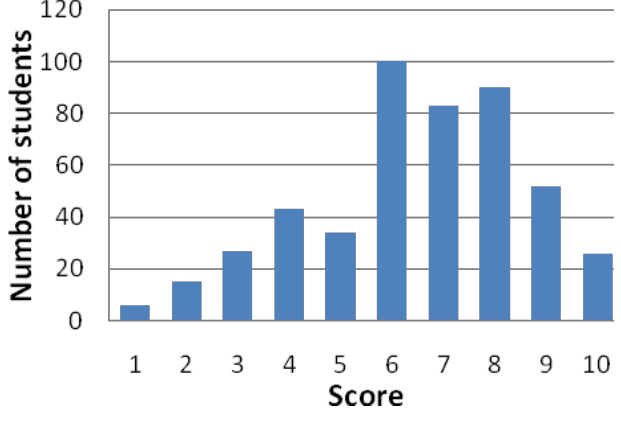
Fig.1. Score distribution of the prior knowledge